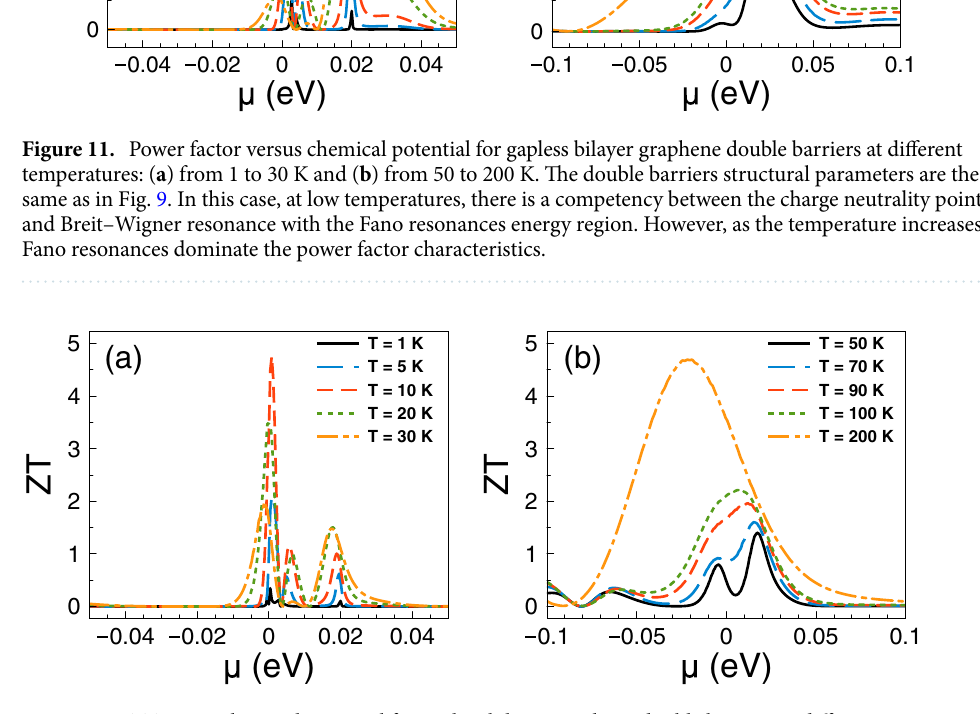
Figure 12. ZT versus chemical potential for gapless bilayer graphene double barriers at different temperatures: ( a ) The range from 1 to 30 K and ( b ) the range from 50 to 200 K. The double barriers structural parameters are the same as in the preceding figures. As in the case of the Seebeck coefficient, the charge neutrality point and Breit–Wigner resonances dominate the ZT characteristics at low temperatures, while the Fano resonances become preponderant as the temperature rises, merging with the charge neutrality point and Breit–Wigner resonances as a single broad peak at high